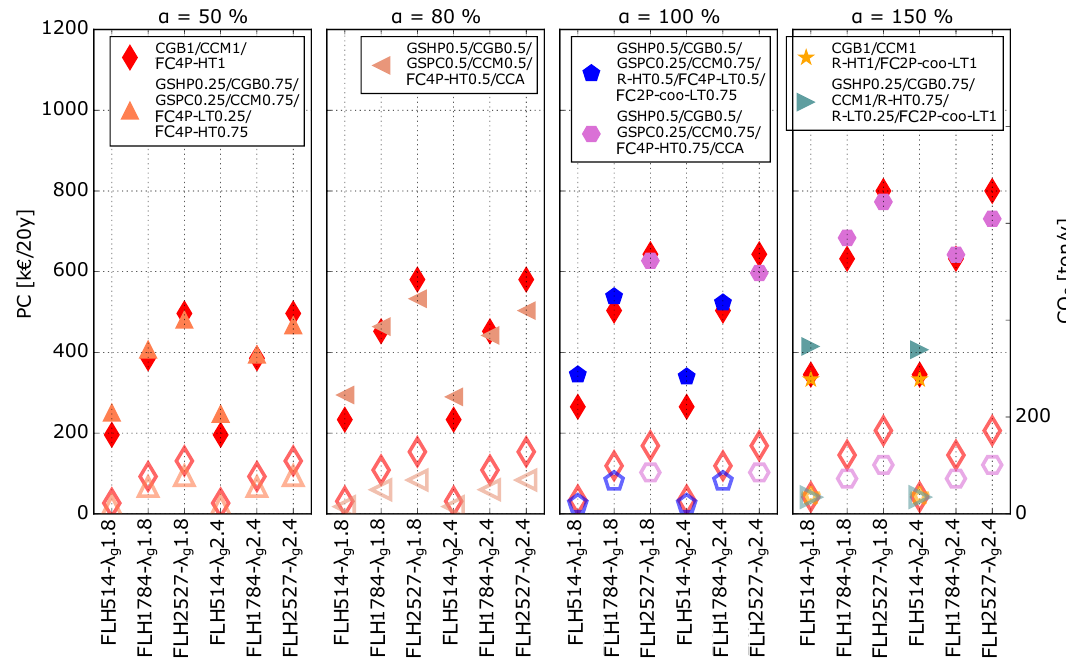
Figure 10. Same as Figure 9, but P spe = 70 W/m 2